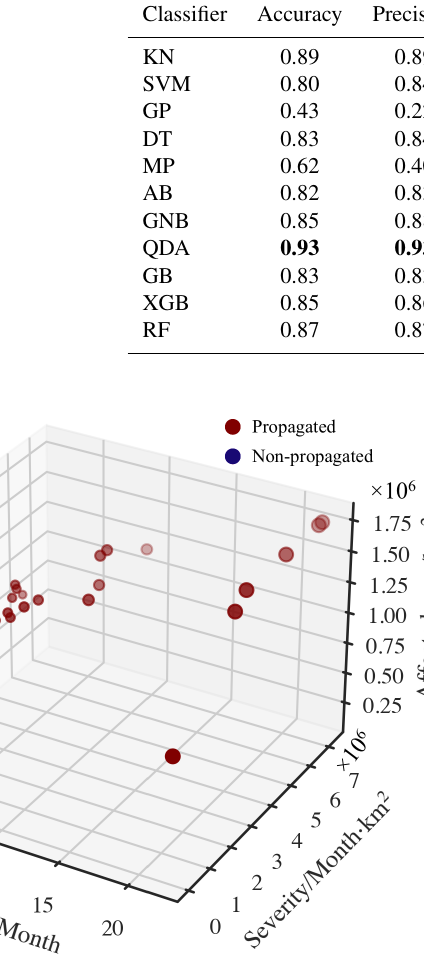
Figure 9. Three-dimensional diagram showing characteristics of meteorological drought events. Larger circles indicate greater sever- ity. Table 5. Goodness of fit of the marginal distribution.